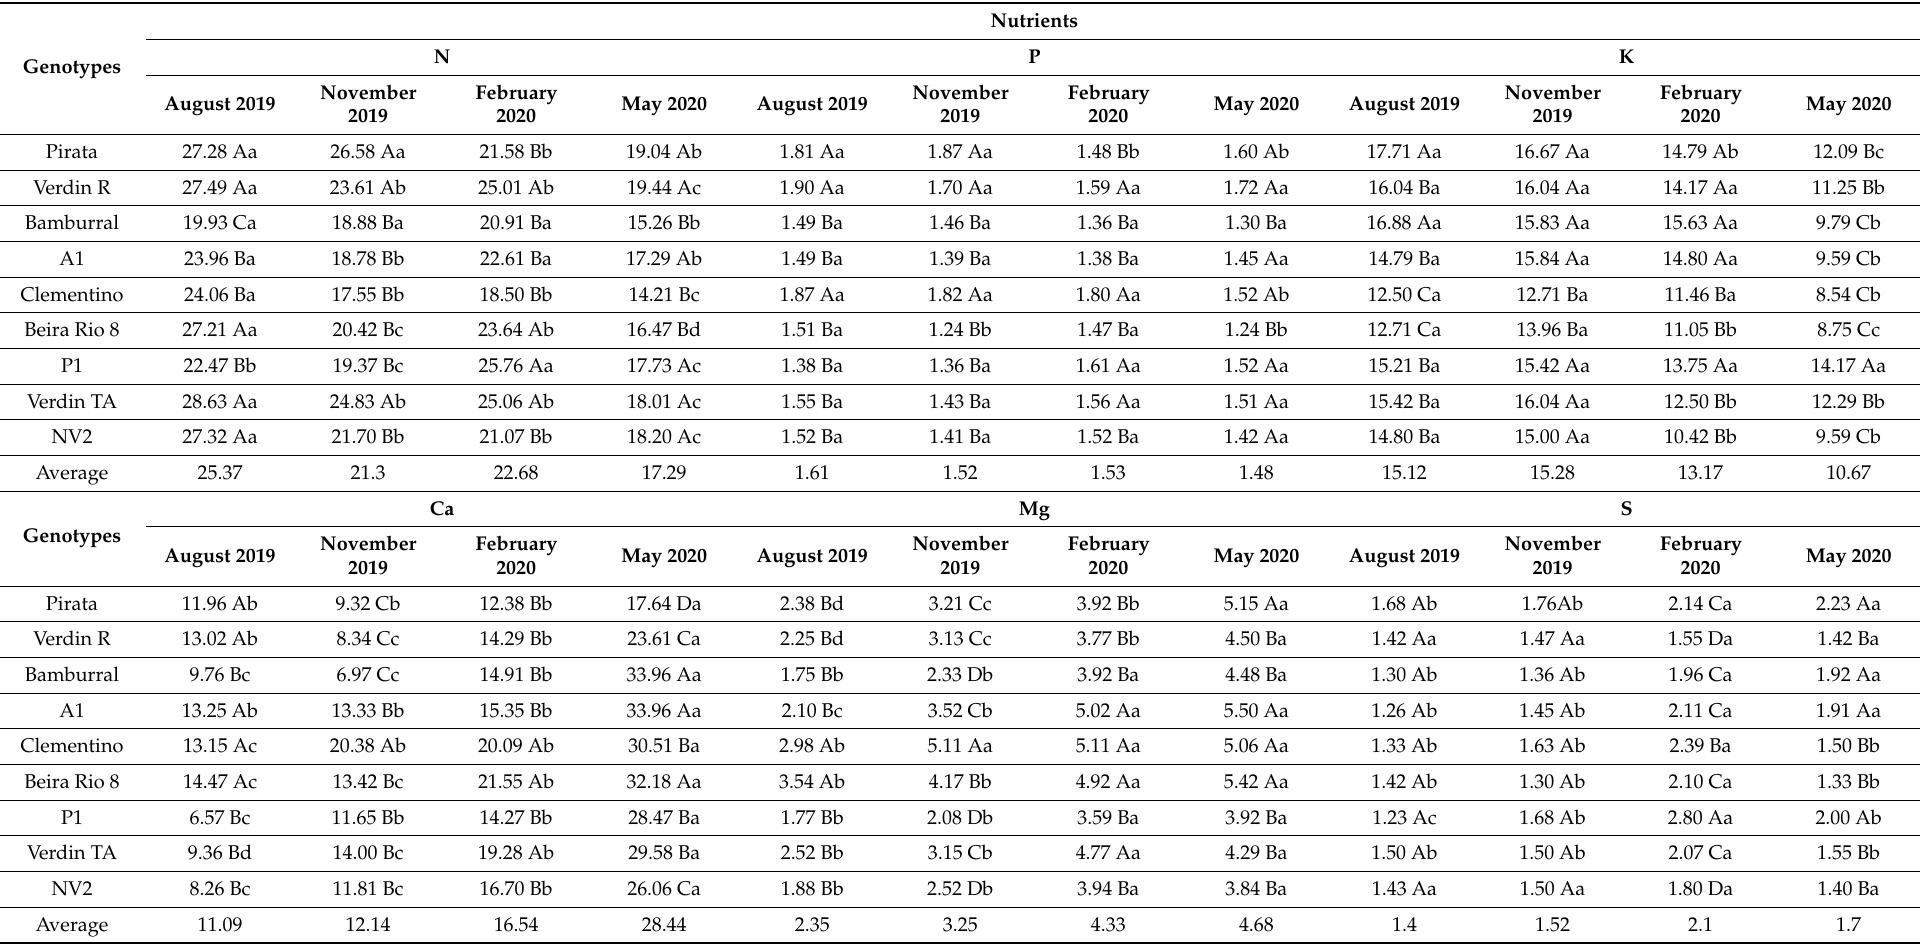
Table 3. Leaf concentration of N, P, K, Ca, Mg, and S (g kg − 1 ) in nine Coffea canephora genotypes for four seasons of the year. S ã o Mateus, state of Esp í rito Santo—Brazil.